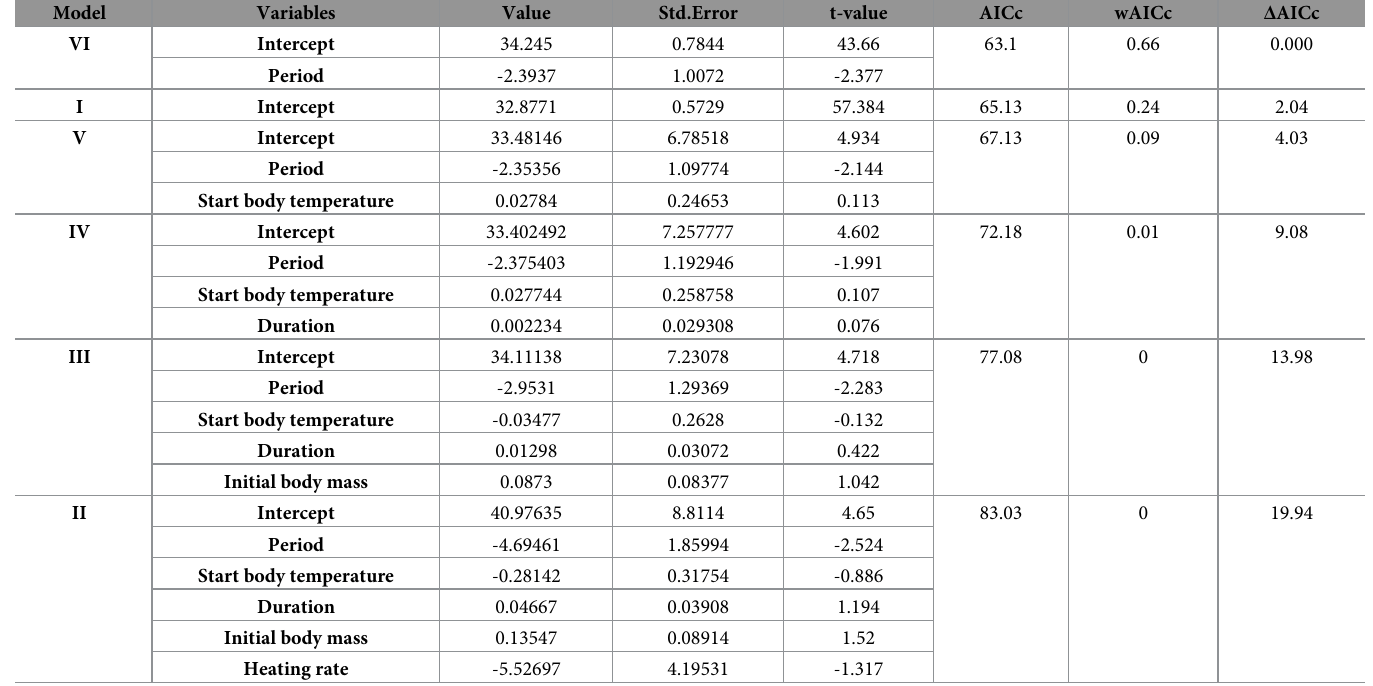
Table 2. Effect of period, start body temperature, duration, initial body mass, and heating rate on the Voluntary Thermal Maximum (VT Max ) of P . nattereri from Estac¸ ã o Ecolo´gica de Santa Ba´rbara, state of S ã o Paulo, Brazil.